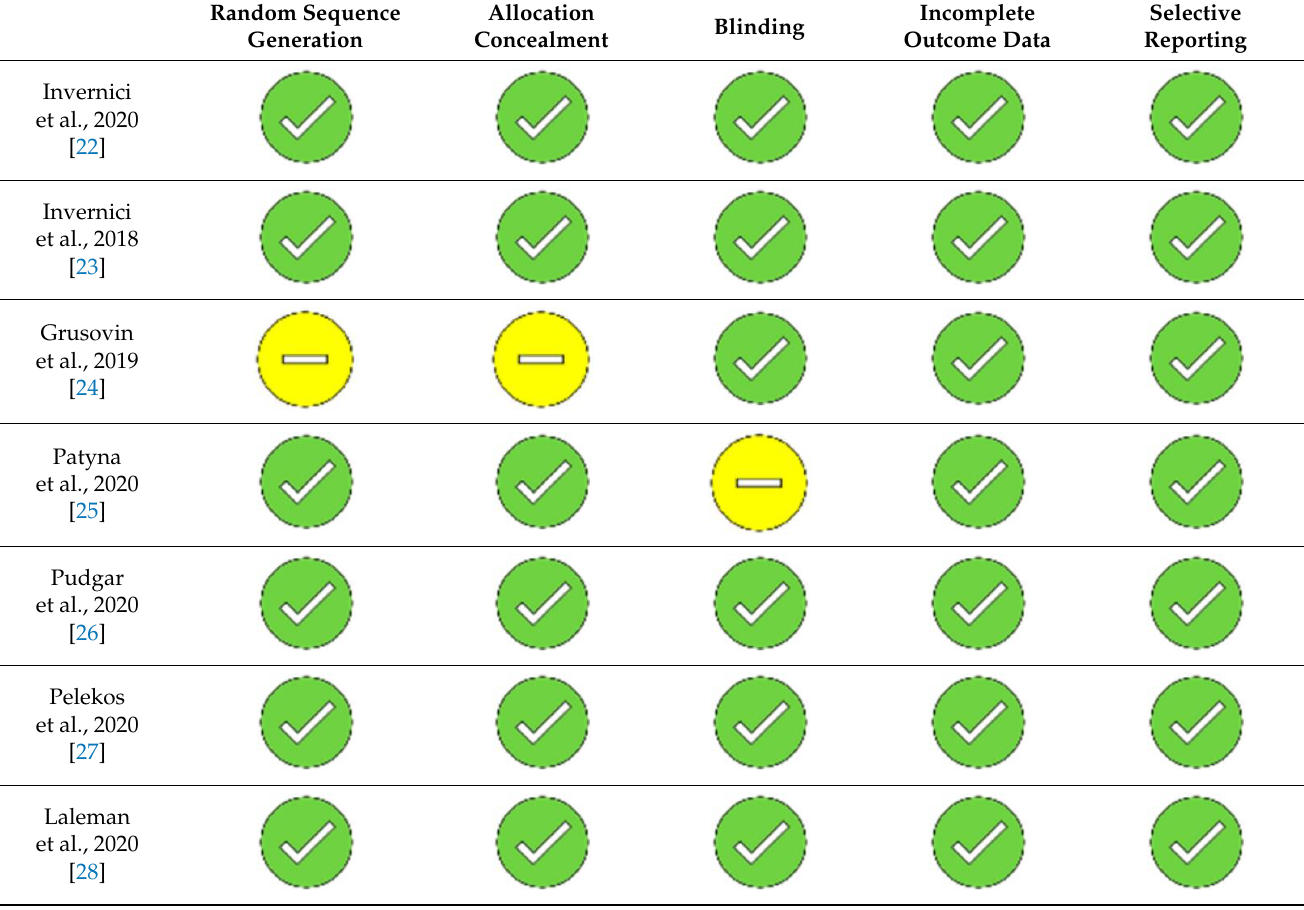
Table 2. Risk of bias (ROB) of the studies included in this review: the green symbol represents a low risk of bias, while the yellow symbol represents a high risk of bias.